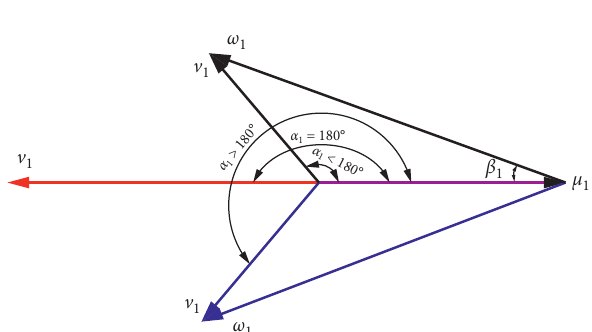
Figure 23: Schematic diagram for determination of the range of the inlet angle.